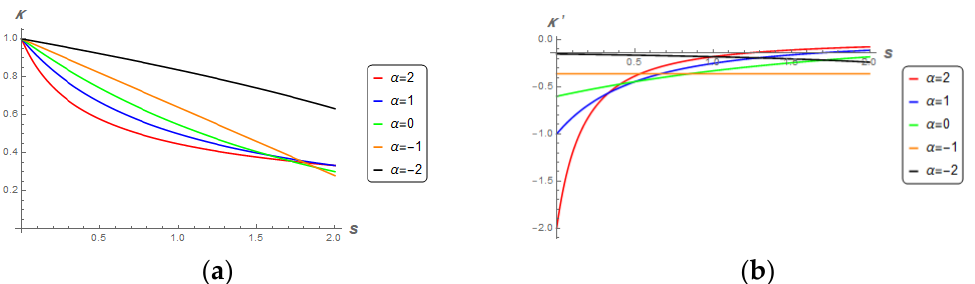
Figure 2. Characteristics of LoCs on LA surfaces of revolution with various types of 𝛼 : ( a ) Curvature of LoCs; ( b ) Derivative of curvature of LoCs.